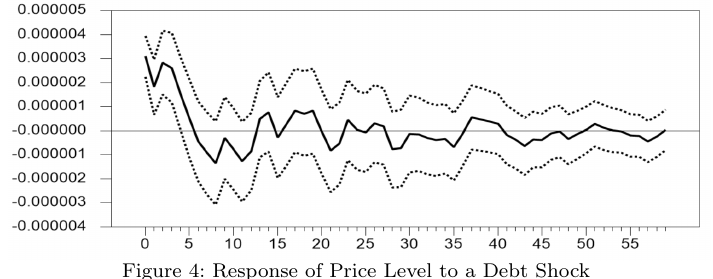
Figure 4: Response of Price Level to a Debt